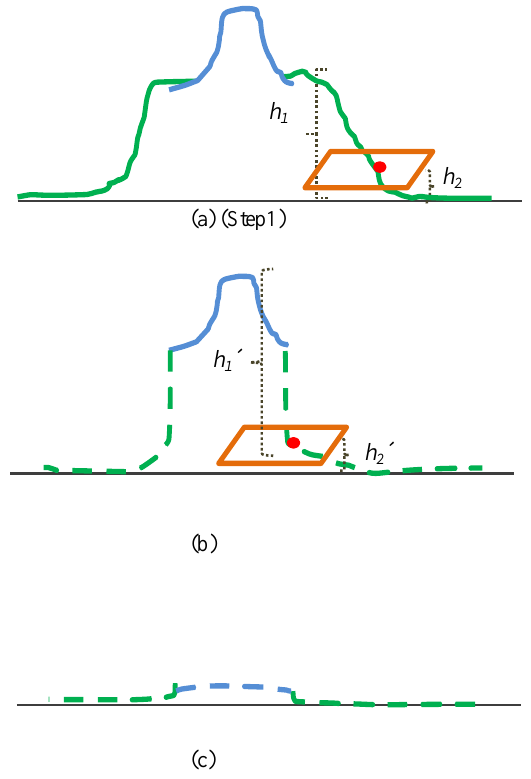
Figure 2. Step down height calculation method (green: low forest, blue: high forest; black: ground